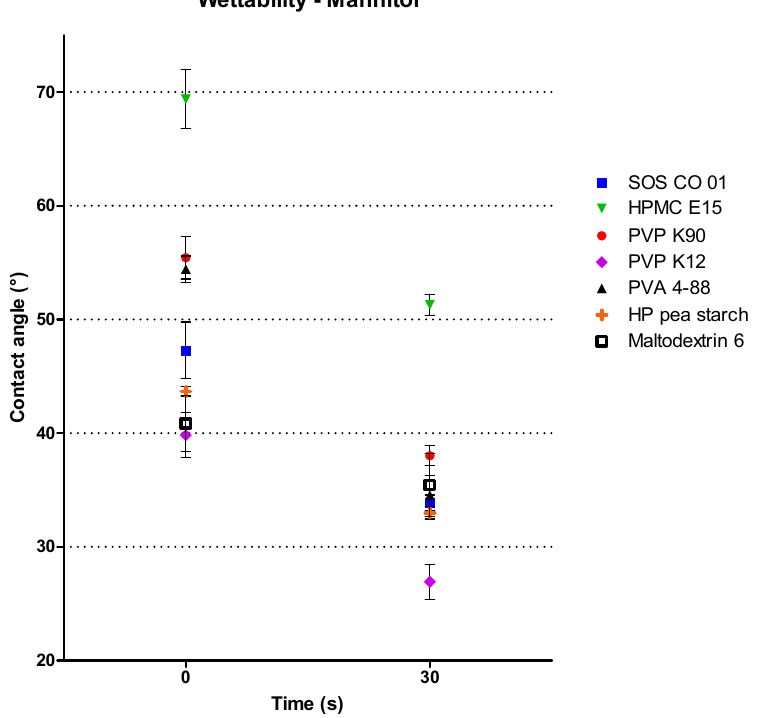
Figure 4. The contact angles of different binder solutions (8% w/w ) measured against mannitol immediately after the binder solution touched the mannitol tablet (t0) and after 30 s